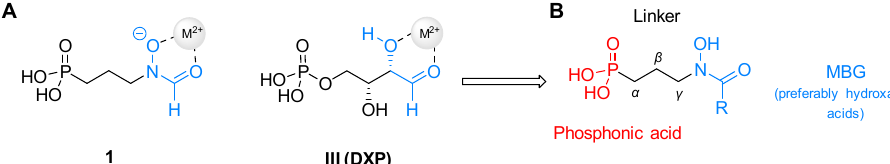
Figure 8. ( A) Binding of 1 and natural substrate DXP ( III ) to a metal ion, represented by a grey sphere. ( B ) Simplified pharmacophore model of fosmidomycin-based DXR inhibitors MGB: Metal- binding group .